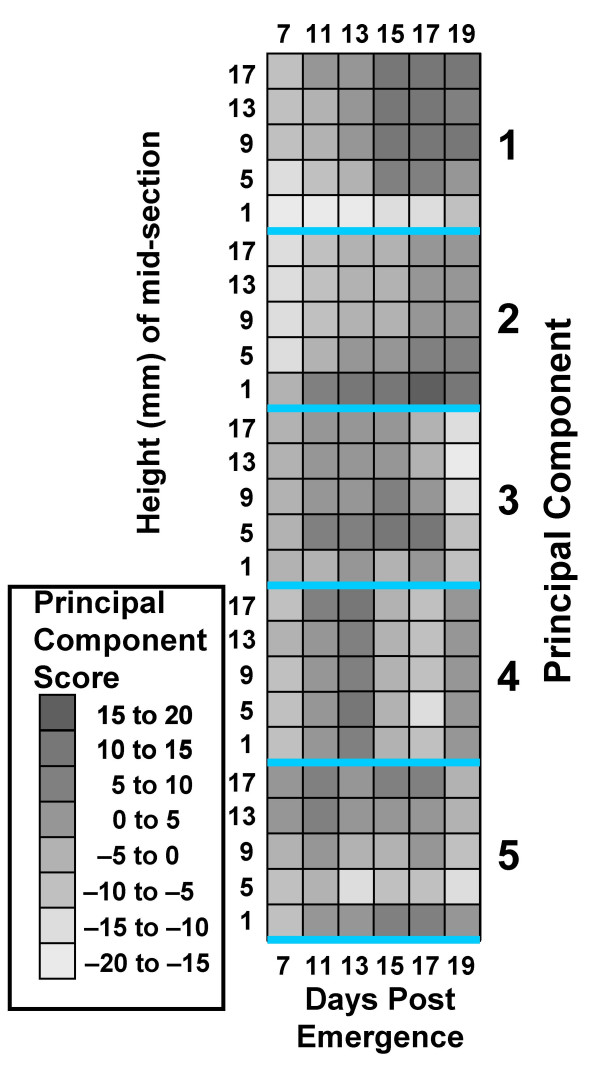
Principal component scores during a rice plant developmental period bridging first tillering. The scores (categorized by value using a grey-scale as indicated in the legend) of Principal Components 1 to 5 (Panels 1 to 5, respectively) are plotted against the progression in sampling of days post-emergence (horizontal axis) and the height of the sampled tissue section (as height [mm] of mid-section – the vertical axis of each panel). Rice plants have a basal meristem, so an increase in mid-section height is also a progression in development. The principal components are of a standardized, centered metabolite space from an analysis of a comprehensive metabolomics dataset. Principal Components 1, 3 and 5 show a pattern of change relative to both developmental variables (axes), while Principal Component 4 and Principal Component 2 (if the influence of the 1-mm mid-section height samples are ignored) vary mainly with days post-emergence and are probably influenced by environment more than development. Each value is the mean of three replicates, each of which pooled sections representing 50 different plants.